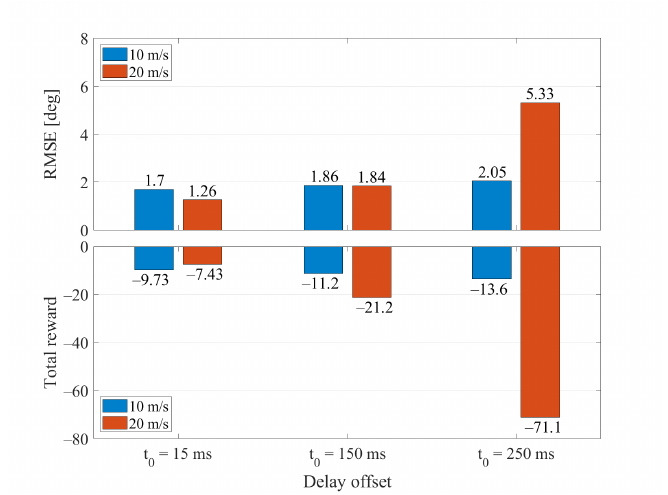
Figure 9. Root mean square error (RMSE) of the angle of attack ( top ) and total reward ( bottom ) for the doublet pitch control when NN0B was used. Wind speeds were 10m/s (blue) and 20m/s